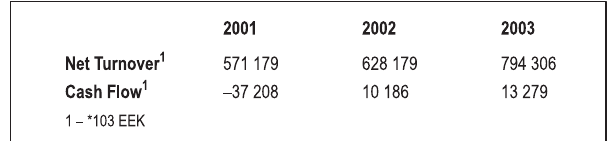
Fig. 4. The consolidated turnover and cash fl ow of TUC